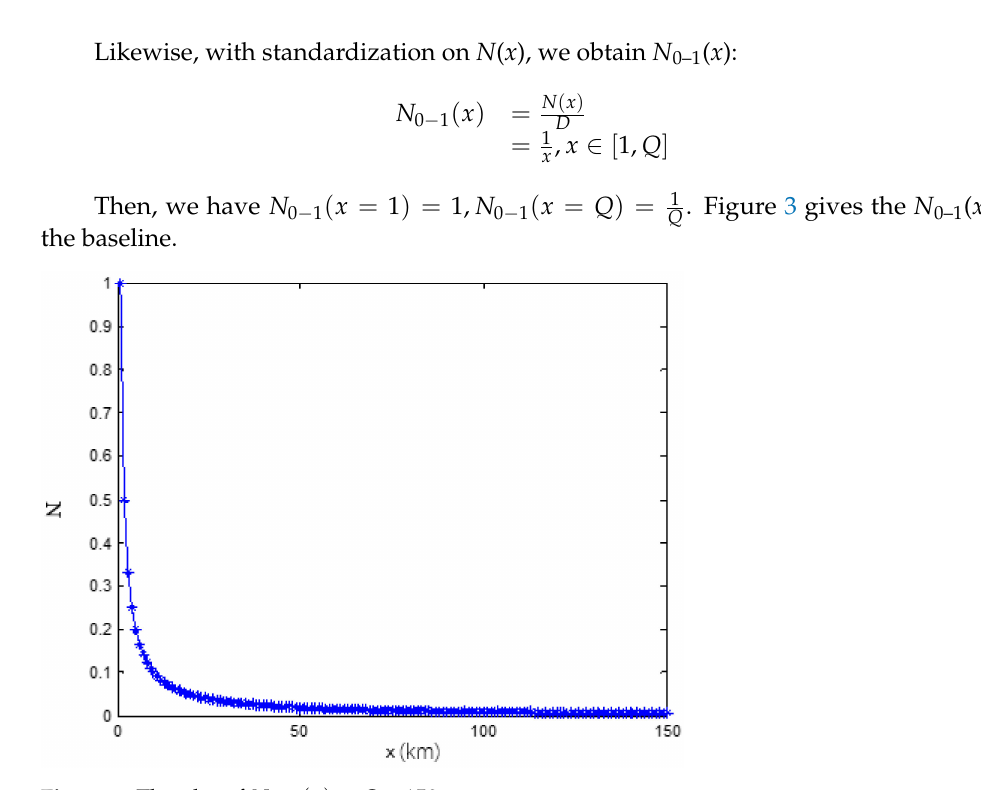
Figure 3. The plot of N 0 − 1 ( x ) at Q = 150.